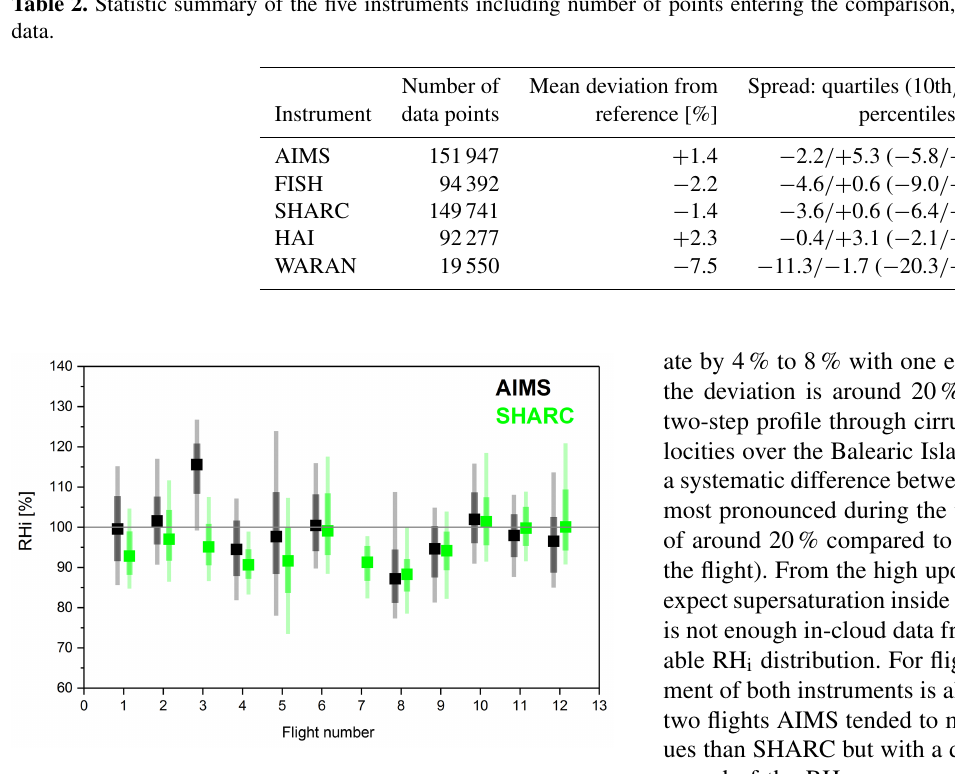
Figure 6. Mean values for RH i inside cirrus measured by AIMS (black) and SHARC (green) for each ML-CIRRUS flight. Broad bars denote the interquartile range; narrow bars denote the 10th– 90th-percentile